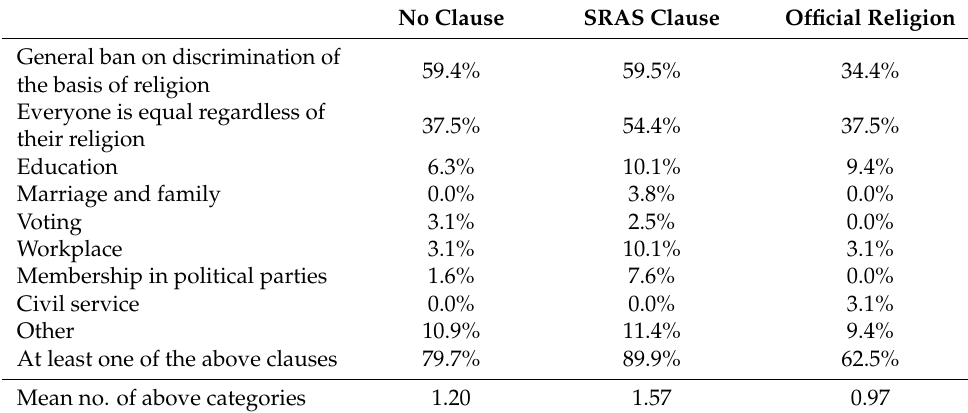
Table 13. Bans on discrimination on the basis of religion in 2014. No Clause SRAS Clause Official